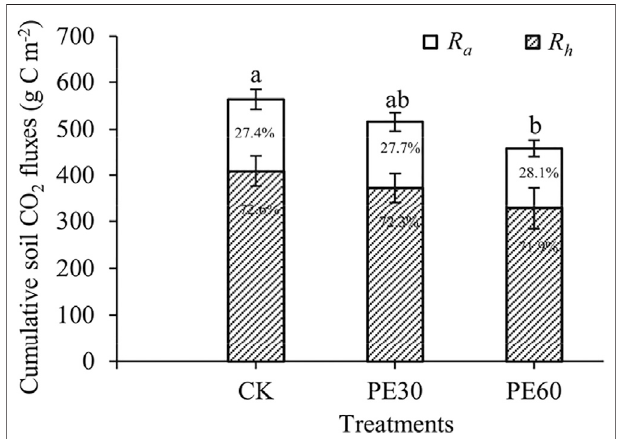
FIGURE 5 | The ratio of heterotrophic respiration ( R h ) and autotrophic respiration ( R a ) to cumulative soil respiration components fl uxes (g C m − 2 ) from August 2016 to July 2017. Letters on the top of the bars indicate signi fi cantdifference among treatments at level of p < 0.05. CK: ambient precipitation; PE30: 30% reduced precipitation; PE60: 60% reduced precipitation.